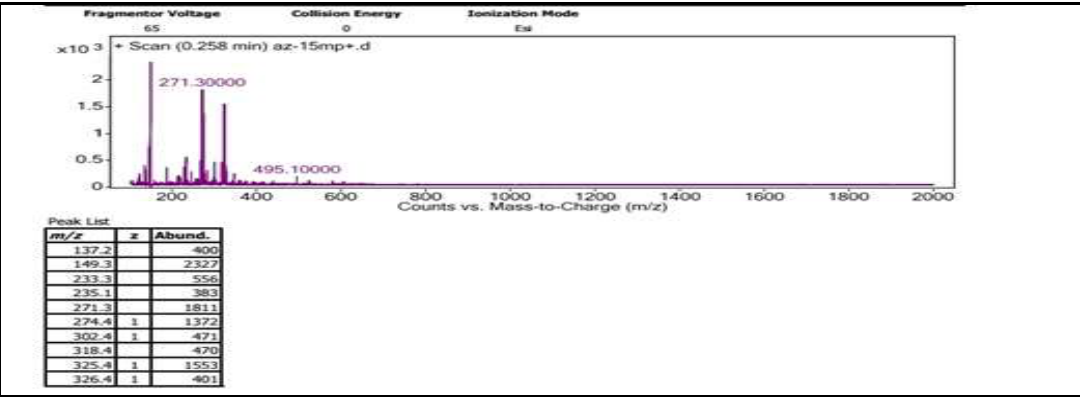
Figure 11.LC/MS for isolated compound A4(1) LC/MS for isolated(A6)(3): the result show in